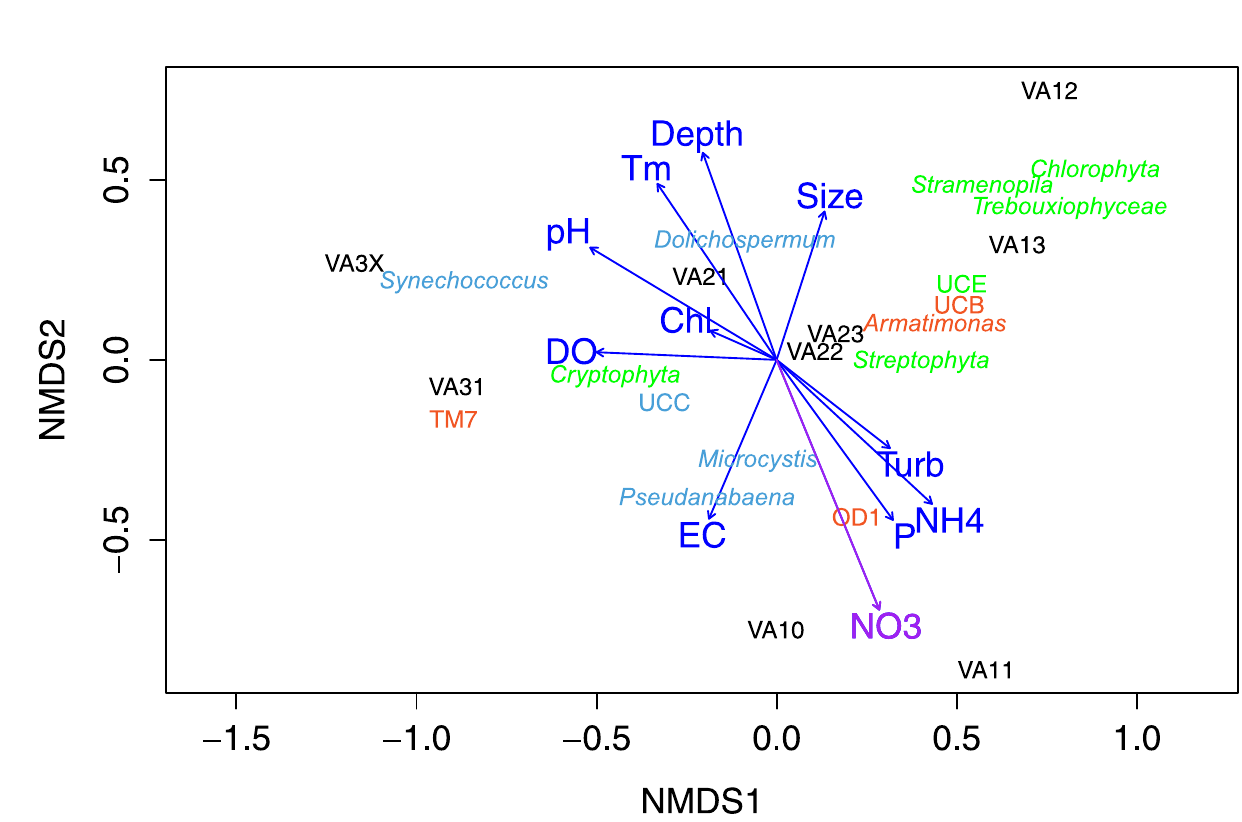
Fig 6. Non-metric Multidimensional Scaling (NMDS) ordination of the variation of taxon compositions in the reservoirs and fitted levels of environmental variables. Directionof the most rapid changes in environmental variables is shown with pointedarrows. The length of the arrows indicatesa proportionto the correlationbetweenordinationand environmental variable. Taxa in green, blue and red are eukaryoticphytoplankton, cyanobacteria and other bacteria, respectively. UCC = unclassifiedcyanobacteria, UCE = unclassifiedeukaryotic phytoplankton, UCB = unclassifiedbacteria. Arrow line in purpleindicates that the parameter (NO 3 ) significantly varied and correlates with the ordinationconfiguration ( P < 0.1) in permutation tests. Chl = chlorophyll a, DO = dissolvedoxygen, EC = electrical conductivity, P = orthophosphate, Tm = temperature, Turb =